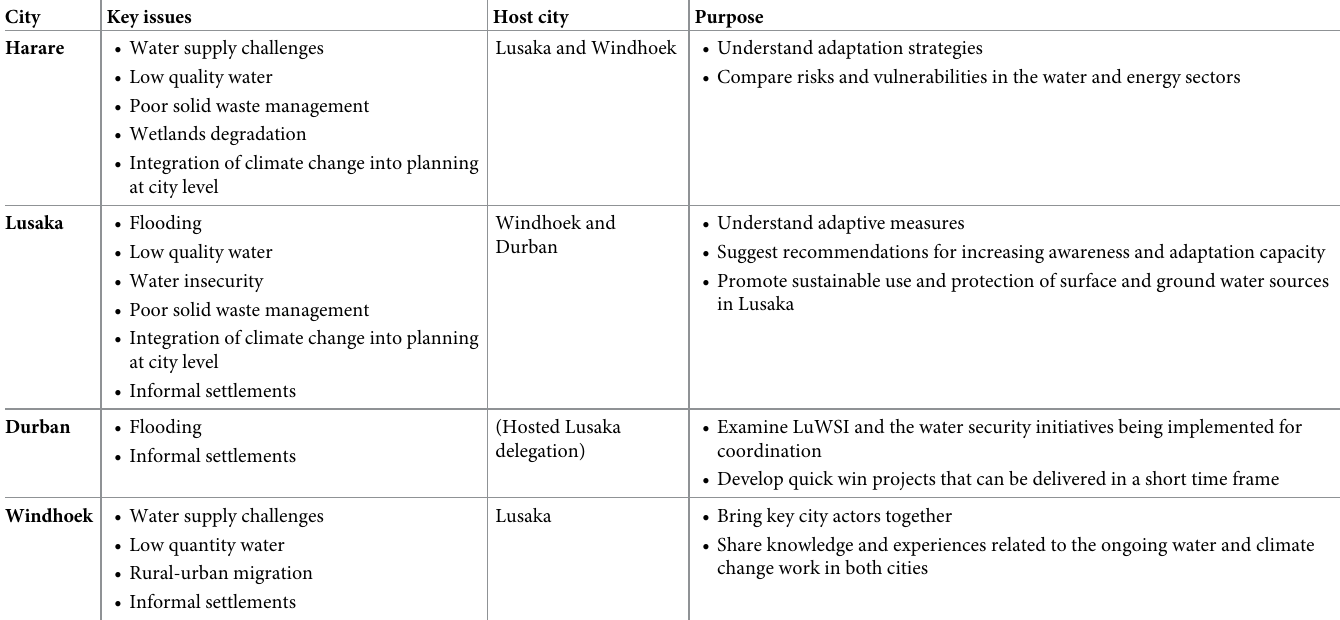
Table 2. Summary of key issues, city exchange visits and visit purpose.